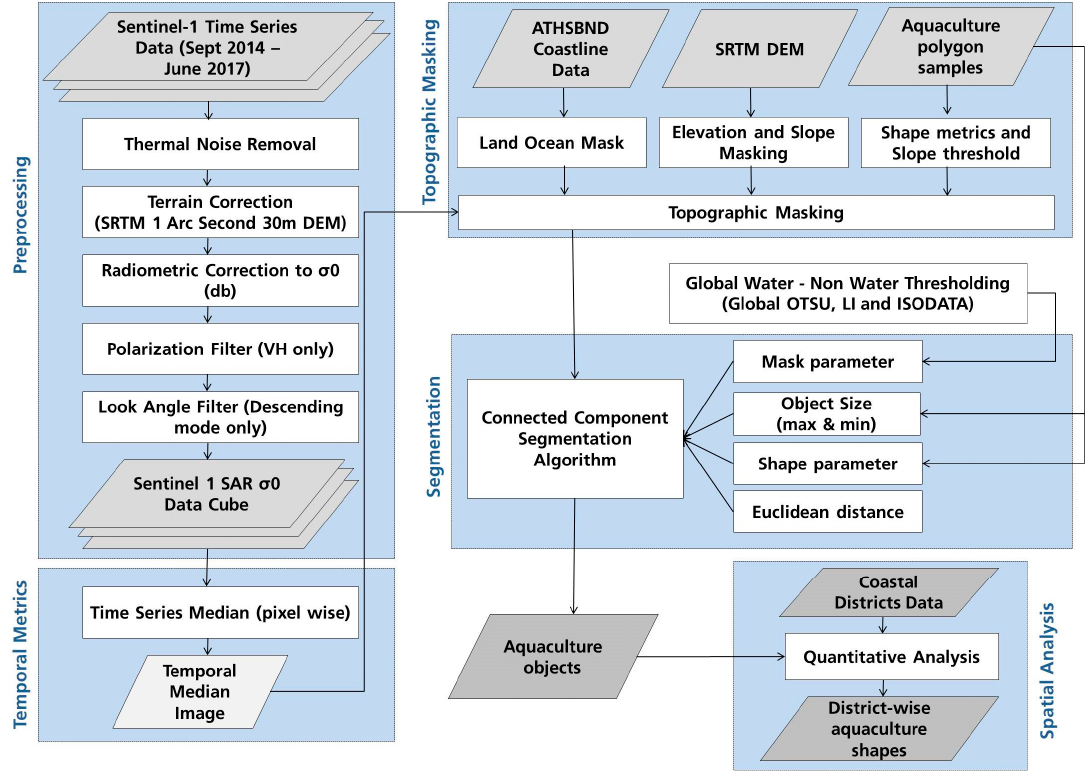
Figure 3. Workflow for aquaculture extraction, adapted from Reference [1].